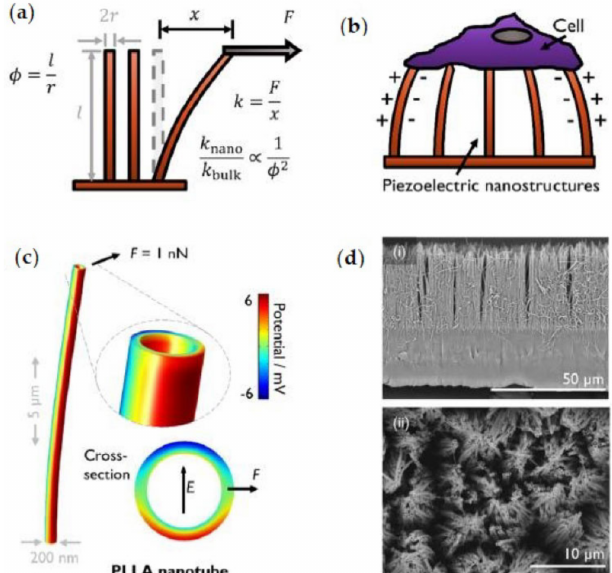
Figure 8. Piezoelectric activity of PLA. ( a ) Schematic of the bending mode of high-aspect-ratio struc- tures with aspect ratio φ , which results in reduced effective stiffness by a factor of φ − 2 with respect to the bulk material. ( b ) Proposed mechanism by which a cell can electromechanically stimulate itself by interacting with the piezoelectric nanostructures. ( c ) Simulation of a PLLA nanotube with axial polymer chain orientation, showing the potential developed in response to bending. Inset shows the opposing potentials developed across the tube diameter and the orientation of the corresponding electric field. ( d ) An example of the PLLA nanotube arrays produced via melt-press template wetting ( i ) in the cross-section and ( ii ) in the plan view. Adapted with permission from Ref. [251]. Copyright 2020, American Chemical